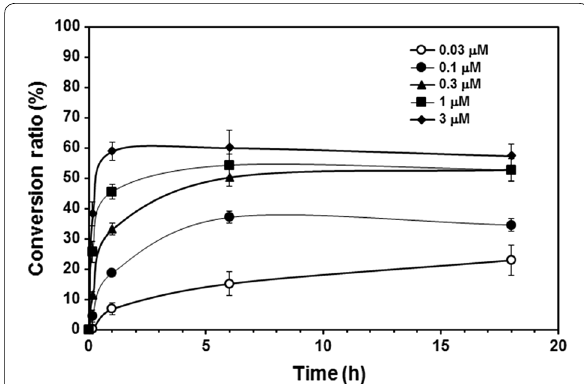
Fig. 3 Time‑course production of ( )‑menthol β‑ d ‑glucoside using − UDP‑ d ‑glucose as a sugar donor with increasing concentration of BLC (0.03–3 μM). The reaction mixtures were incubated for 10 min, 1, 6, and 18 h and quantitatively analyzed by LC–MS/MS in MRM mode according to “Materials and methods”. The error bars represent the standard deviation of three independent experiments